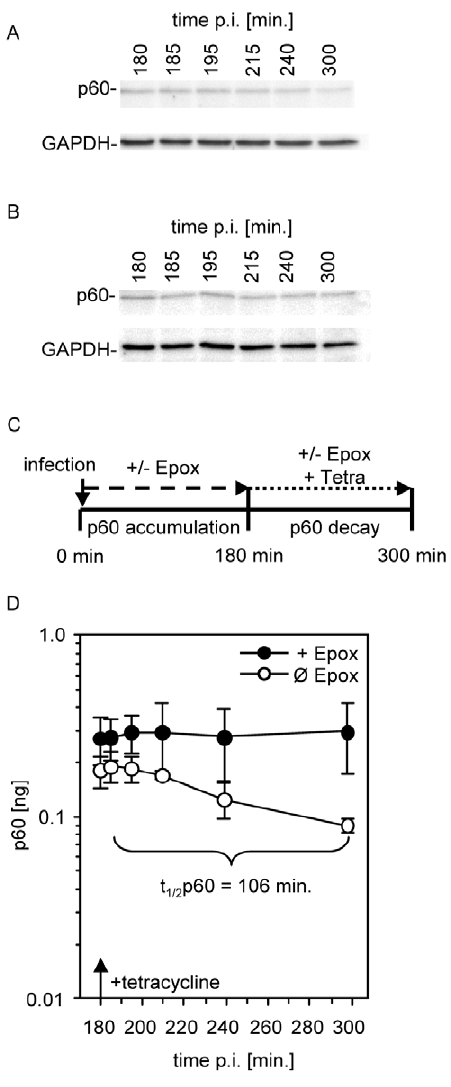
Figure 3. Half-life of p60 in L. monocytogenes -infected cells. Three hours after infection further bacterial protein synthesis was inhibited by tetracycline treatment of cells and intracellular p60 was detected by western blot at the indicated time points either in the absence (A) or presence (B) of epoxomicin as shown in the schematic drawing (C). By interpolation with an external p60 standard the total amount of p60 per 100.000 cells was calculated in the presence ( + EPOX) or absence (Ø EPOX) of epoxomicin (D). Shown are the means and standard deviations of three independent experiments.